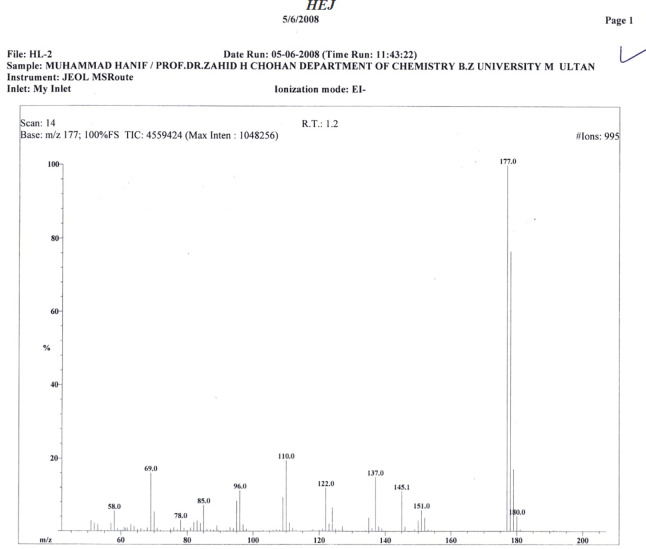
The significantly higher yields of the product under ultra-sound mediated conditions may be attributed to the phenomenon of cavitations.The passing ultra-sound waves generate small bubbles in the reaction medium. These bubbles have energy trapped in them. These bubbles when combine form larger bubbles and hence large energy. When these bubbles rupture, the release energy which is sufficient enough to allow the reactant molecules overcome the energy barrier required for a specific reaction. The reaction under ultra-sound condition was significantly fast and all reactions afforded desired compounds as exclusive products in excellent yields.